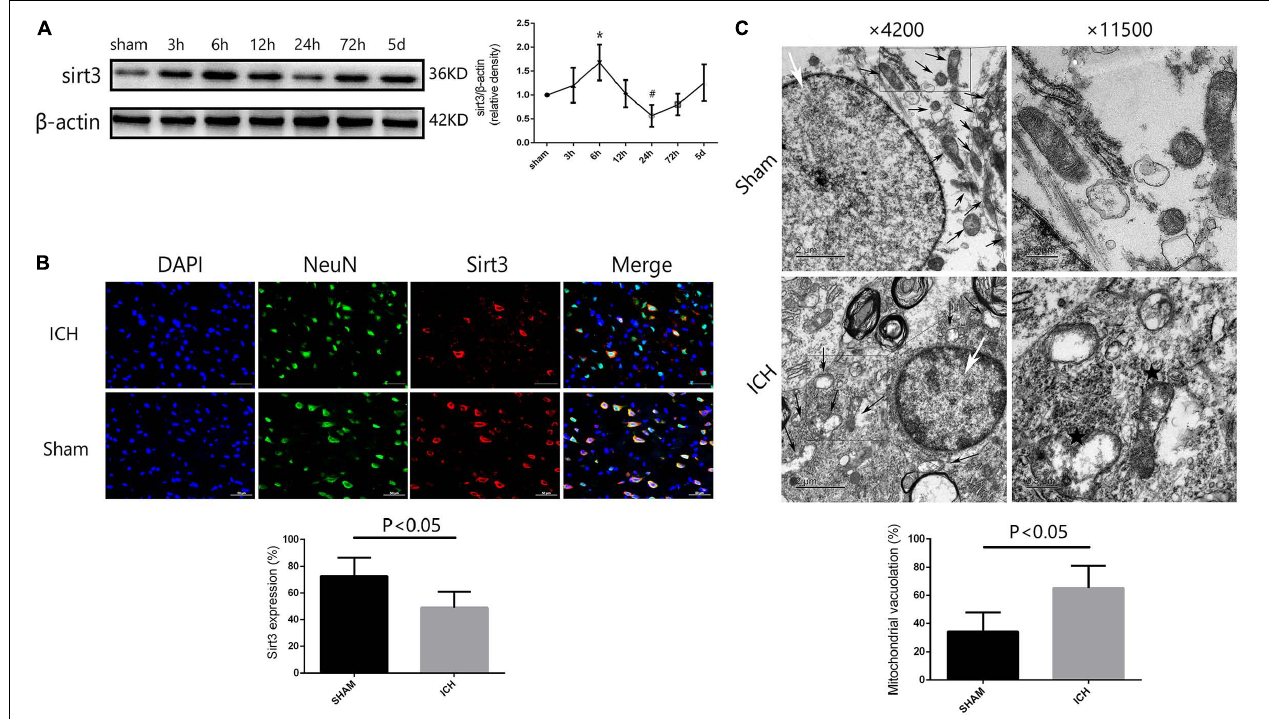
FIGURE 2 | Sirt3 protein expression and morphological changes of mitochondria after hyperglycemic ICH. (A) Western blotting showed that sirt3 protein expression was significantly decreased to the minimum at 24 h after ICH. Before that, sirt3 expression was reactively upregulated at 6 h after ICH, ∗ P < 0.05 versus sham group, # P < 0.05 versus the rest groups ( n = 6 in each group at different time points). (B) Immunofluorescence staining showed the location of sirt3 protein in basal ganglia after hyperglycemic ICH at 24 h. Sirt3 expression was downregulated after ICH when compared with sham group ( P < 0.05, 18 cryosections from 6 rats were calculated in each group, scale bars: 50 µ m). (C) Transmission electron microscopy images of neuronal apoptosis and mitochondrial ultrastructure (white arrow: cell nucleus; black arrow: mitochondria). The ratio of mitochondrial vacuolization was increased after ICH when compared with sham group ( P < 0.05, 18 TEM images from 6 rats were calculated in each